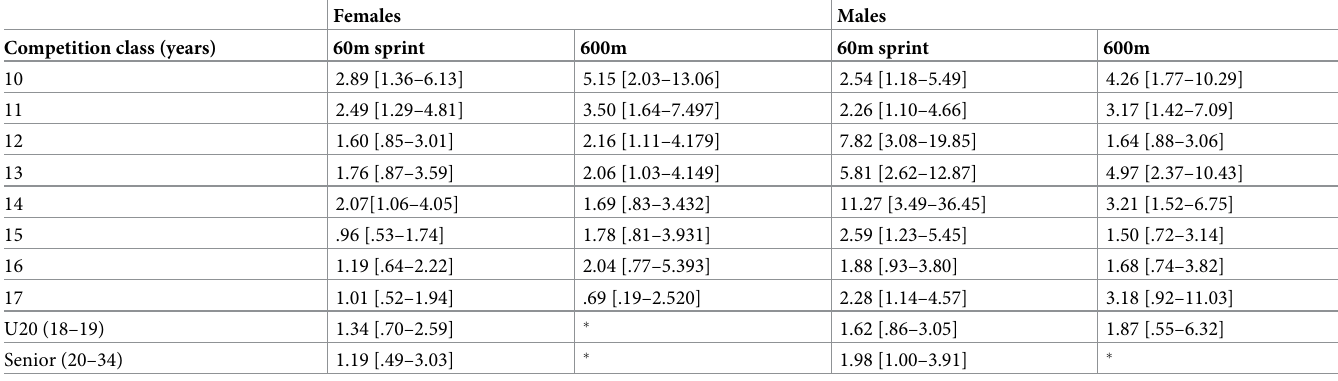
adolescents of both sexes have an advantage in youth track and field both in sprint and mid- dle-distance running. Better performance in both sprint and middle-distance running among athletes born early in the year compared to those born late can probably be explained by the Table 3. On overview over OR 95% [CI] of being among the top-100 athletes and born in Q1 compared to Q4.